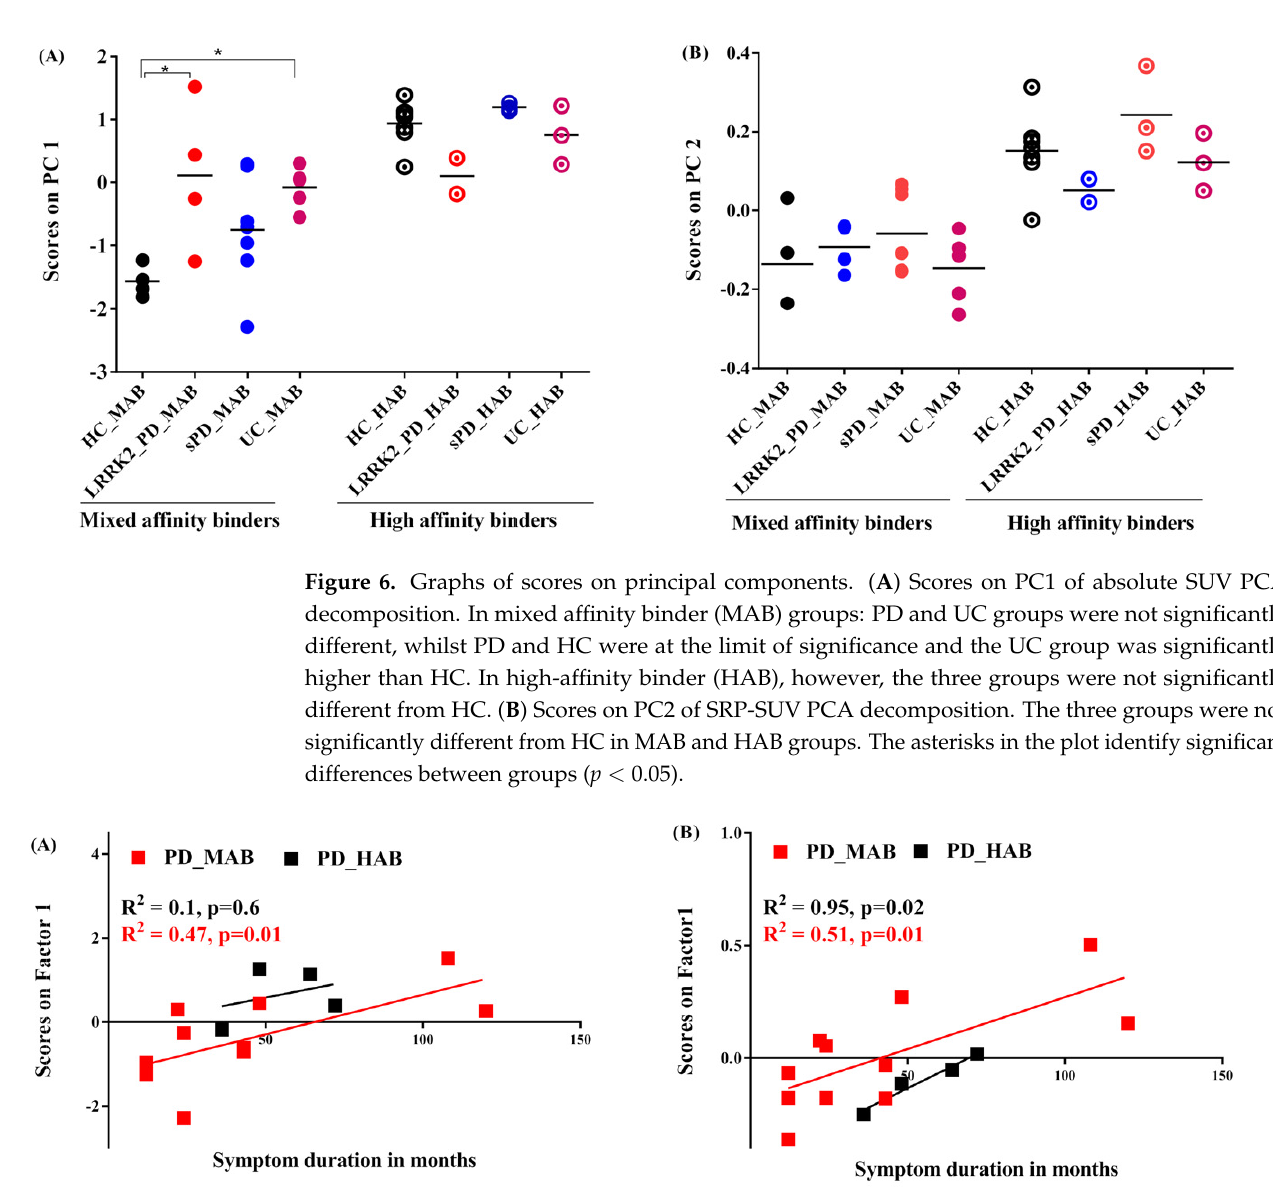
Figure 7. Correlation between symptom duration and principal components. ( A ) PC1 of absolute SUV PCA decomposition positively correlates with Parkinson’s disease patients with mixed affinity binder (PD-MAB). ( B ) PC1 of SRP-SUV PCA decomposition significantly correlates with PD-MAB and with HC-HAB (R 2 = 0.51, p = 0.01 and R 2 = 0.95, p = 0.02,